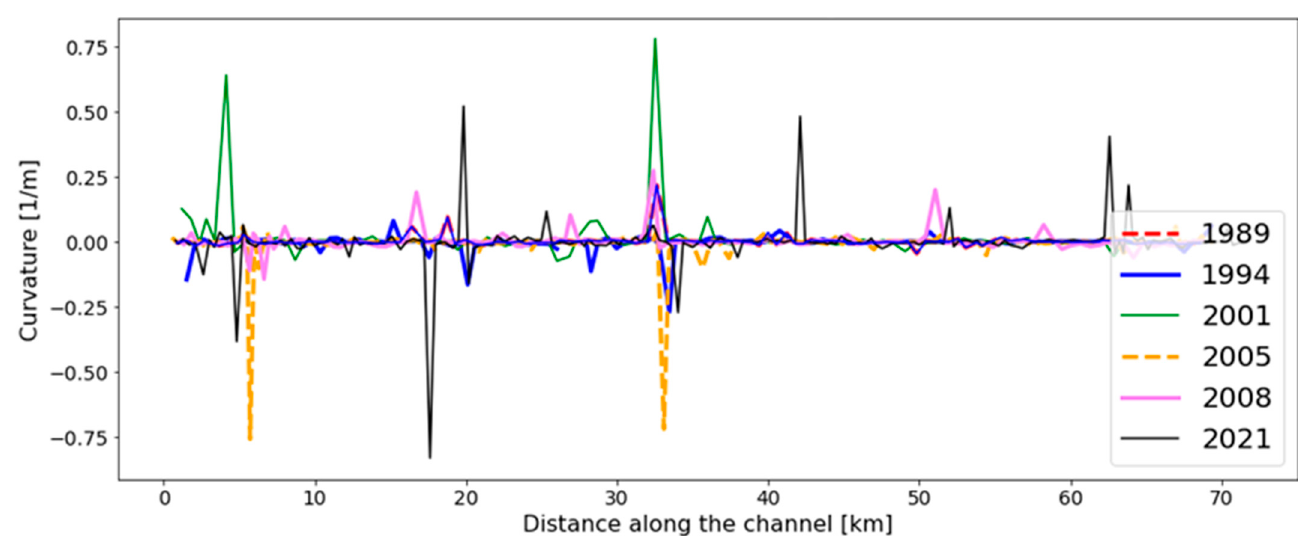
Figure 7. Spatiotemporal variation of curvature along the river centerline.